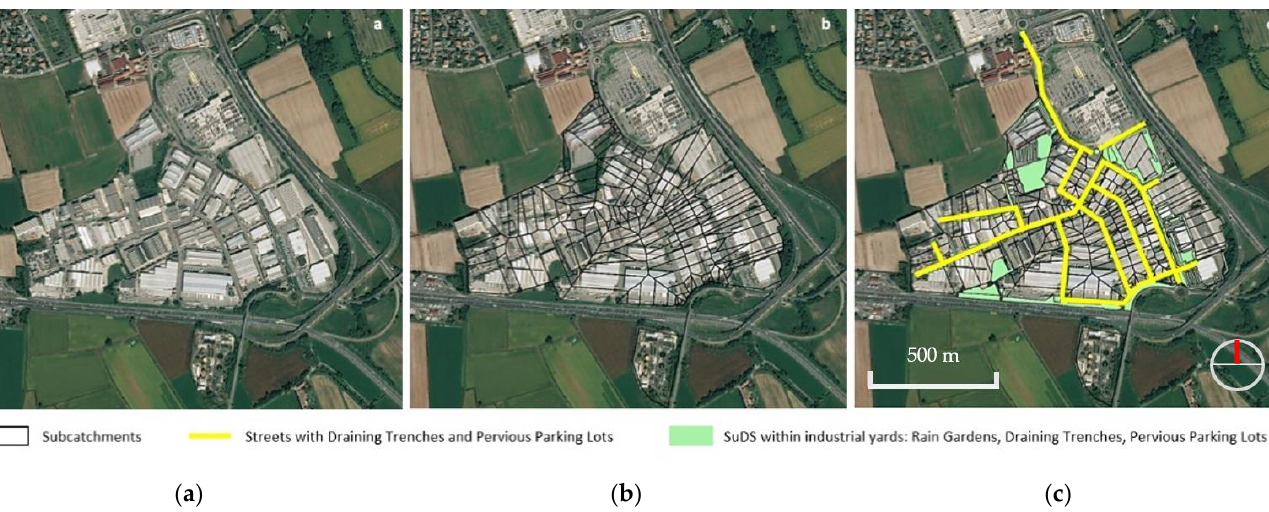
Figure 4. Catchment C ( a ), subdivision into subcatchments ( b ), and SuDS distribution within the subcatchments ( c ).